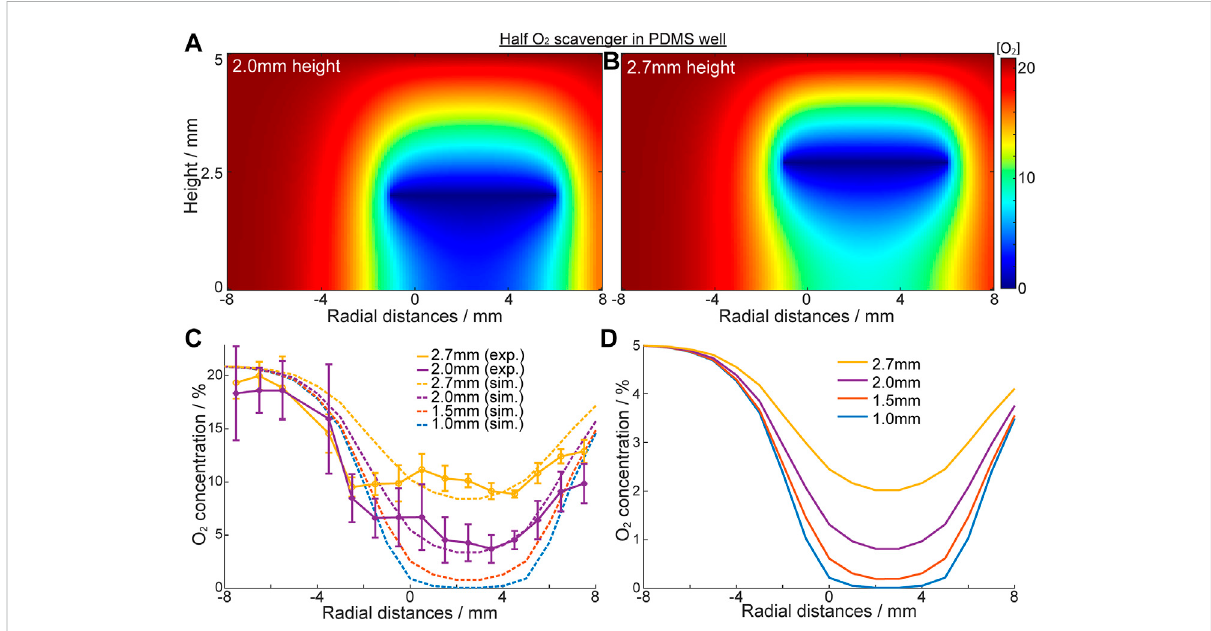
FIGURE 4 Characterisation of oxygen concentration “ patterning ” with “ half ” scavenging electrode at -1mm – 6 mm. (A,B) Heat map of oxygen concentrationofthesolutioninsidethePDMSwellwithano fl uxbasein[O 2 ] ambient =20.9%.Oxygenscavengingelectrodeisahalfcircle,positioned at 2.0 mm (A) and 2.7 mm (B) height. (C) Oxygen concentration across the well base when electrode is placed at different heights. Solid line: experimental results; dotted line: simulation results. (D) Simulated [O 2 ] in the same system when [O 2 ] ambient = 5% (cell culture